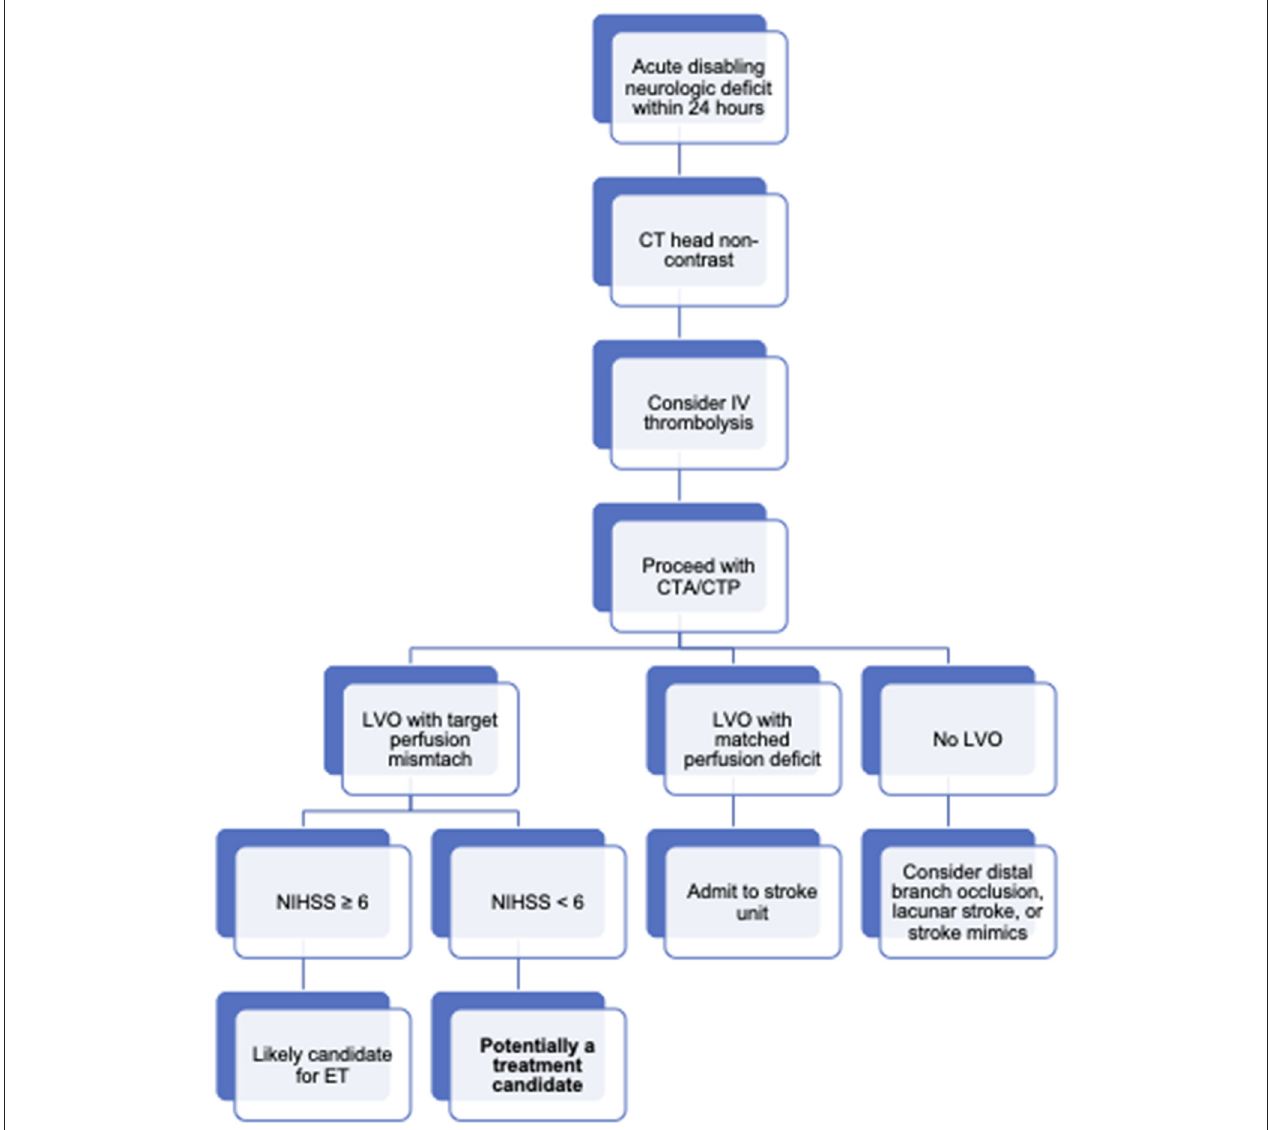
FIGURE 2 | Treatment diagram for patients with a LVO and mild stroke symptoms. Board overview of workflow for acute ischemic stroke patients at our institution. In general, patients with an acute neurologic deficit (even those scoring low on the NIHSS) will be taken for non-contrast head CT if stroke is clinically suspected. In the absence of intracranial hemorrhage or early ischemic changes, patients may be considered for thrombolysis if symptoms remain diabling and the patient is within 4.5 hours of symptoms onset. Extended window thrombolysis is considered on a case-by-case basis and is not depicted here. Patients treated with thrombolysis and patients not treated with thrombolysis but still suspected to have an acute stroke clinically are further imaged with CT angiography and perfusion. Identification of an LVO and a target perfusion mismatch profile (CBF < 30% volume of < 70 cc, mismatch ratio ≥ 1.8, mismatch volume ≥ 15 cc) leads to activation of the stroke interventional team. Patients with NIHSS scores of 6 or more points are usually treated with ET. Patients with NIHSS < 6 are